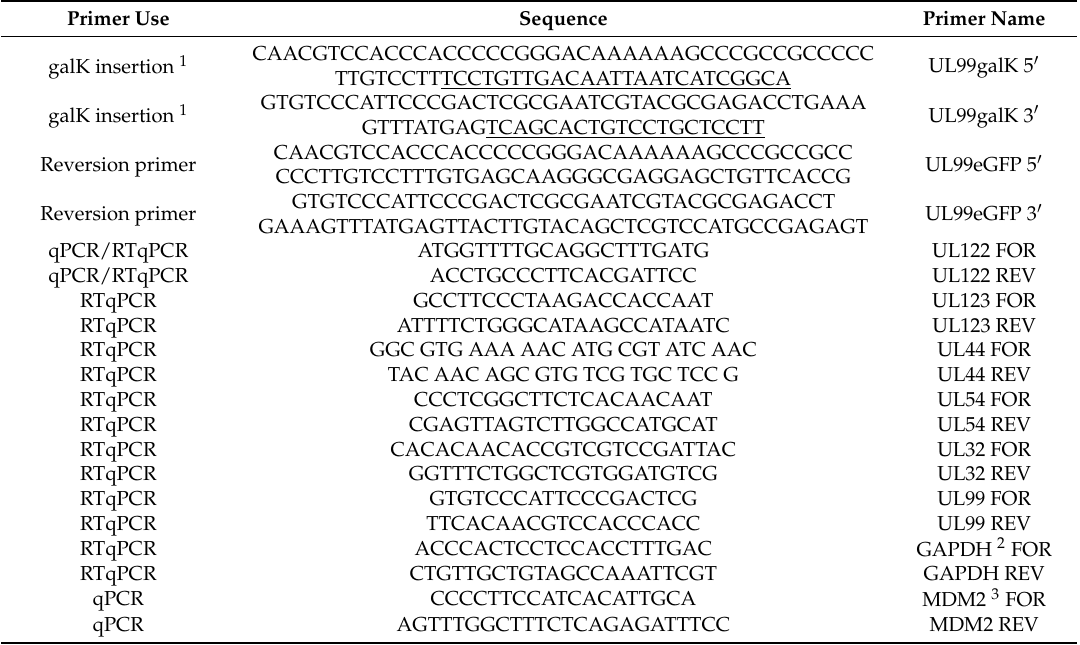
Table 1. Primers used in this